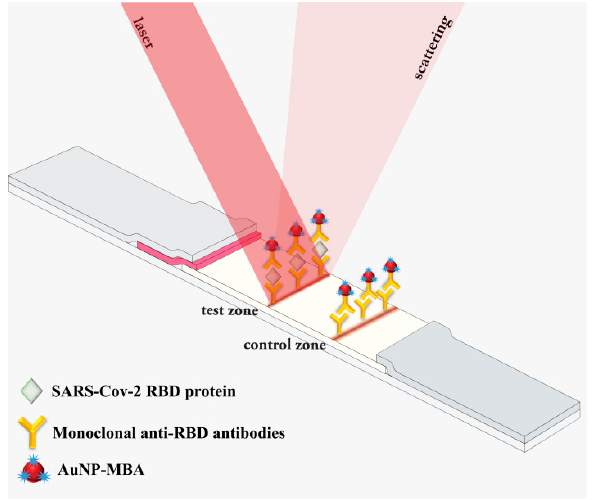
Figure 1. Schematic principle of SERS-based LFIA for RBD protein detection using SERS nanotag.